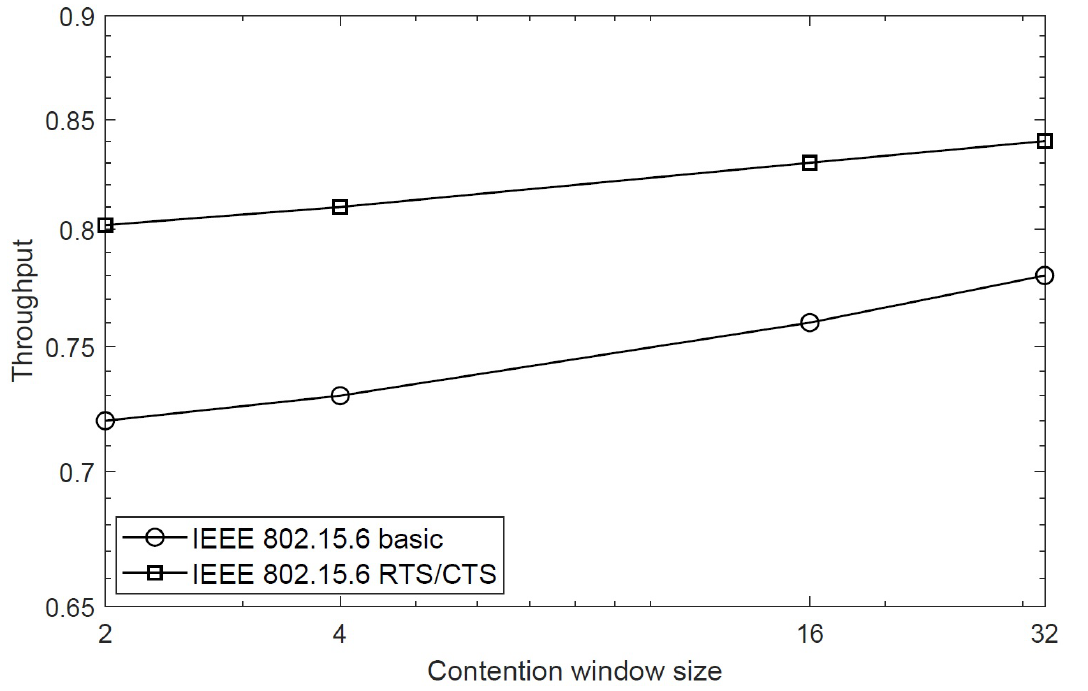
Figure 7. Saturation throughput of the RTS/CTS scheme for different contention window